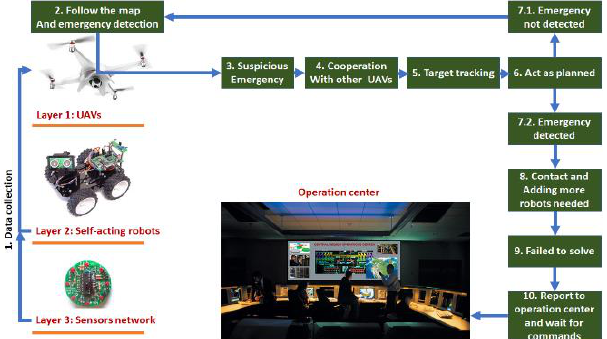
Figure 2 . Information processing steps and actions of the